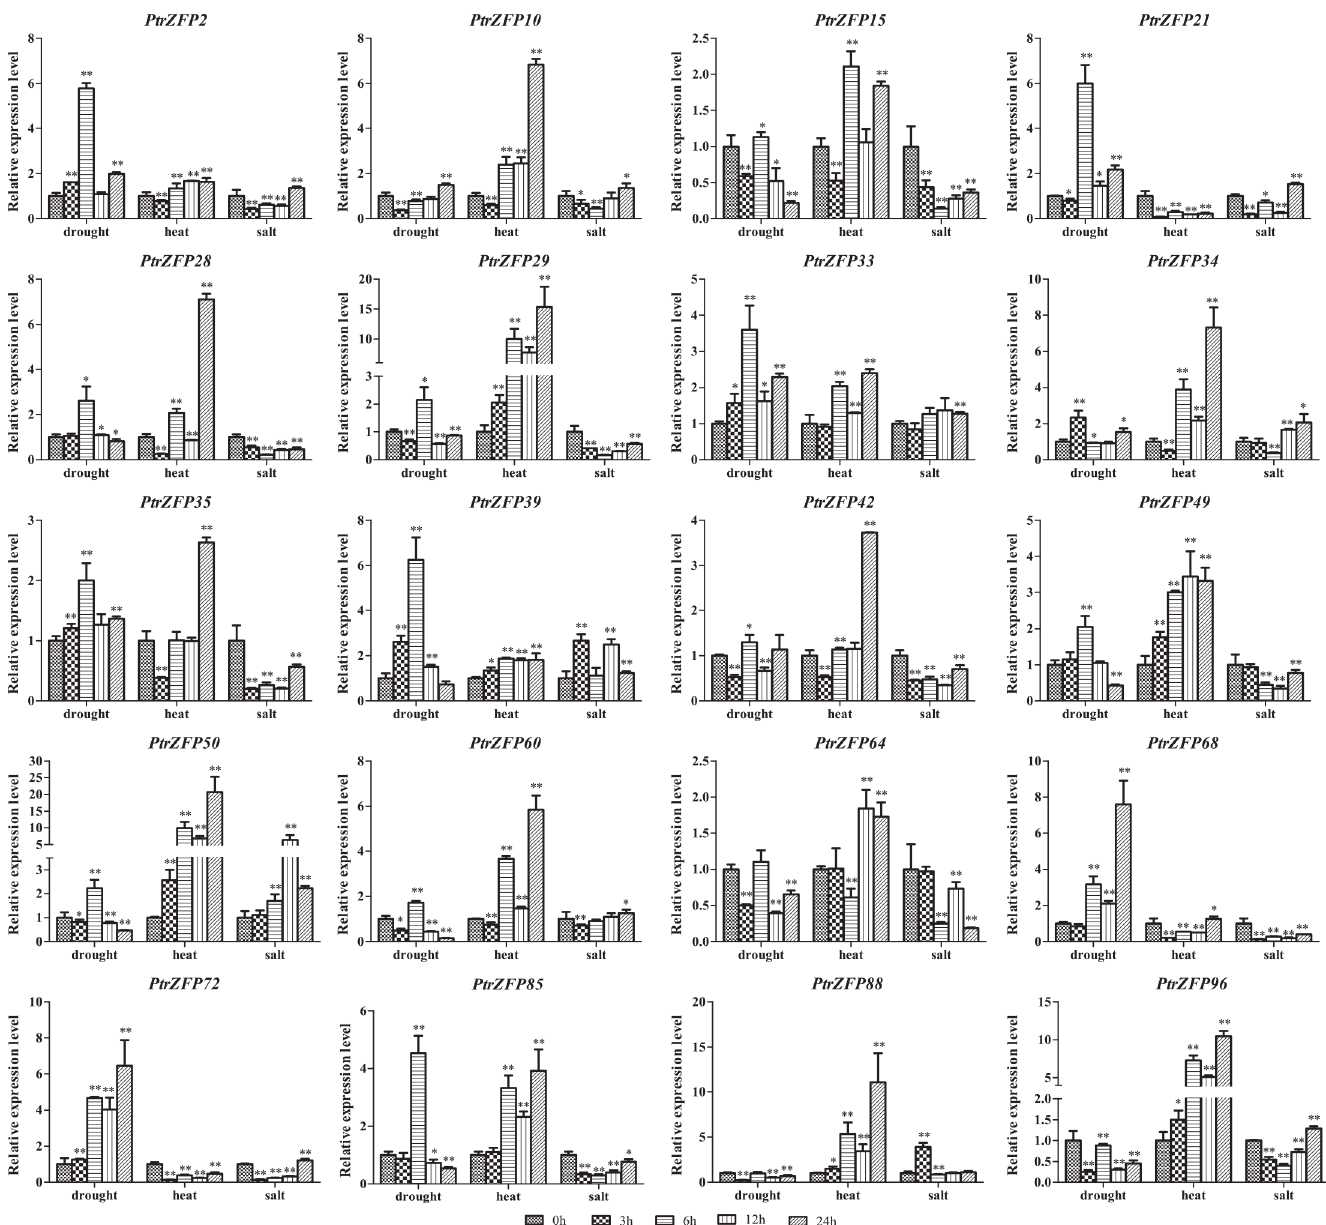
Fig 8. Expression analysis of 20 selected C2HC2-ZF genes in roots under drought, heat and salt stresses using qRT-PCR. The relative mRNA abundance of 20 selected C2HC2-ZF genes was normalized with respect to the reference gene ( Actin1 ). The x -axis represents time points after stress treatments. Error bars represent the standard deviations from three biological replicates. Asterisks indicate stress treatment groups that showed a significant difference in transcript abundance compared with the control group ( * P < 0.05, ** P < 0.01).